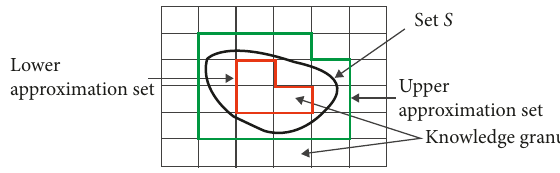
Figure 1: Graphical representation of a rough Table 1: An example of an information table of house purchasing.